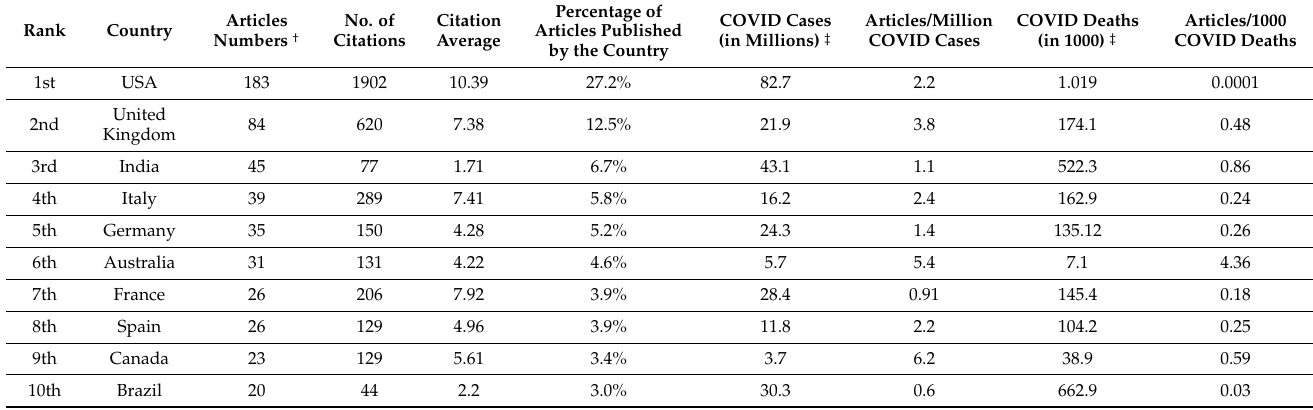
Table 3. Top 10 productive countries on PC-related COVID-19 publications.